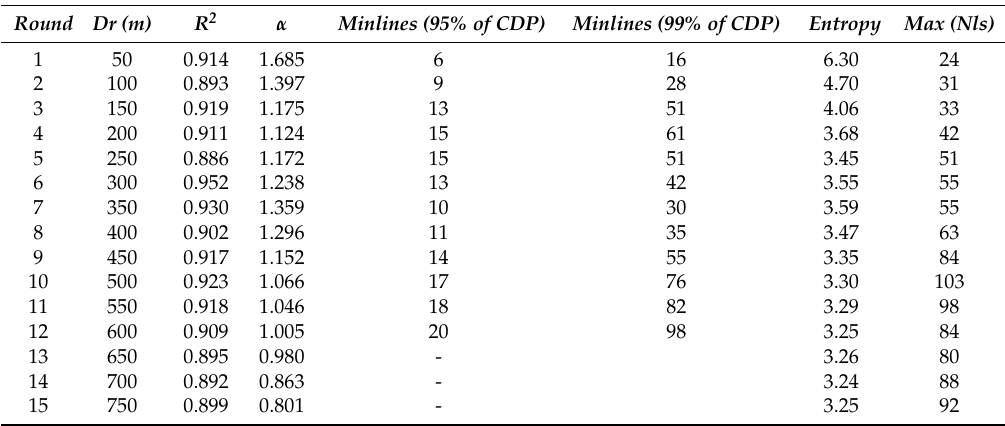
Table 1. Statistical results for different radius from round 1 to round 15.